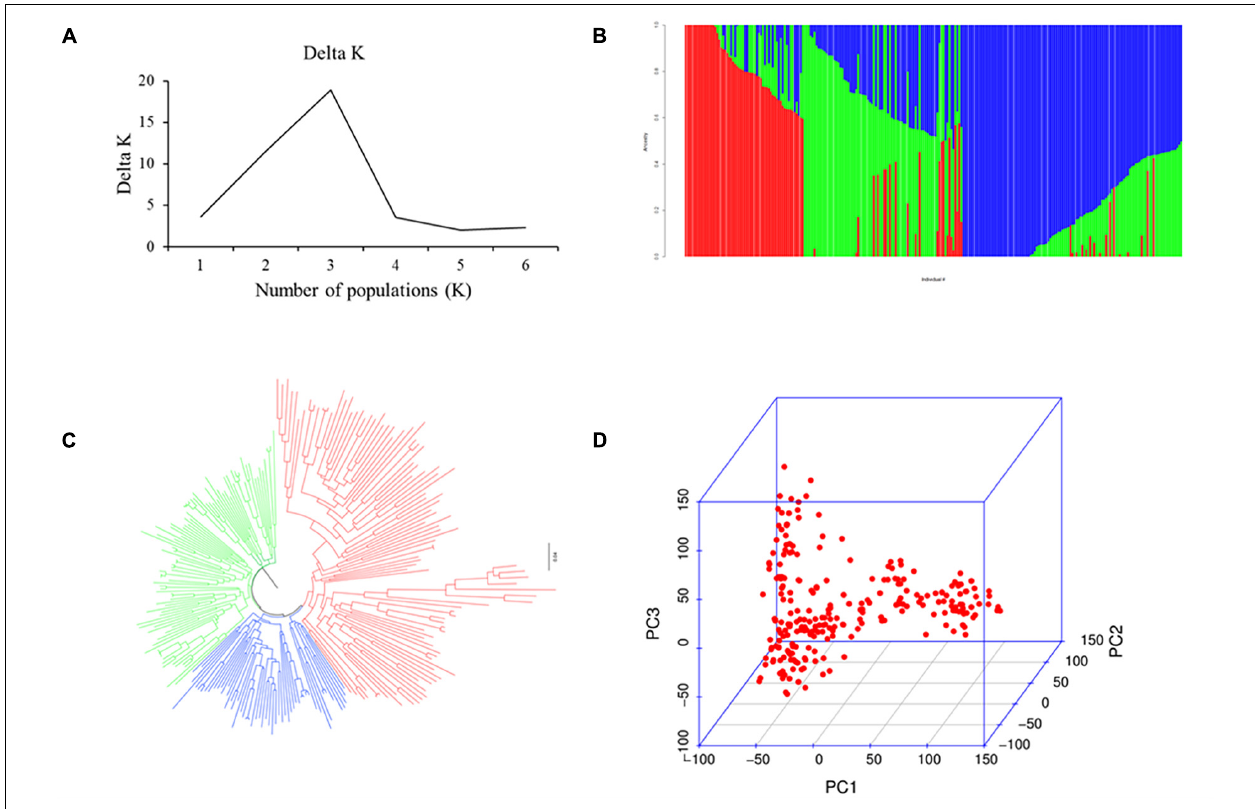
FIGURE 1 | Population analysis for the 251 spring wheat accessions. (A) Delta K for structure analysis. (B) Population structure analysis. (C) Neighbor-joining (NJ) tree. (D) Principal components analysis (PCA) plots.